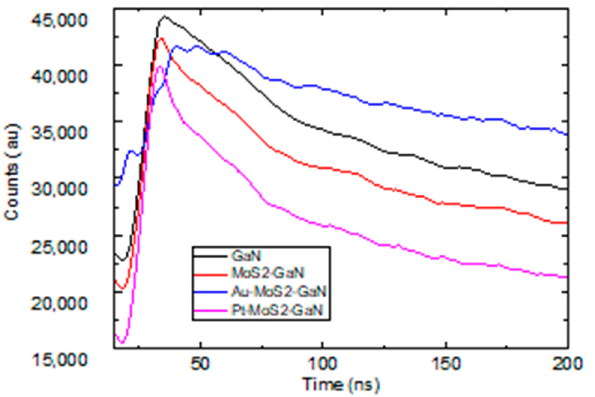
Figure 3. Time-resolved photoluminescence decay time of the defect band showing slower recom- bination LT with Au plasmons (blue) and faster recombination LT with Pt plasmons. The black and red curves represent the TRPL characteristics of GaN and MoS 2 -GaN, respectively.